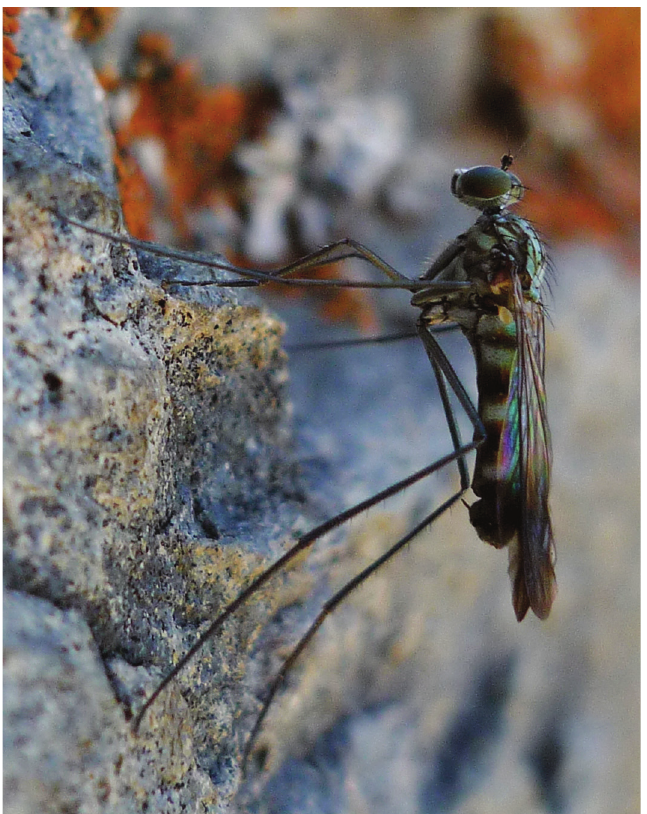
Figure 9. Habitus photograph of male Liancalus similis Aldrich taken at Palisade Falls in Gallatin County, Montana on 12 October 2012. Note very short cerci. Photo taken by Justin